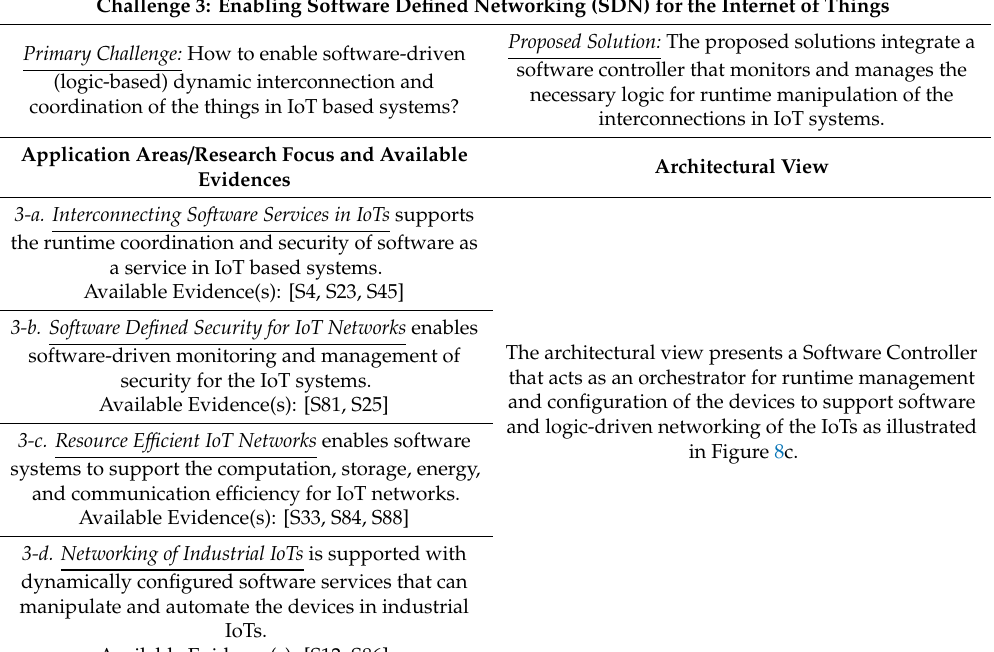
Table 7. Challenge III— Overview of the challenges and architectural solutions for software defined networking for